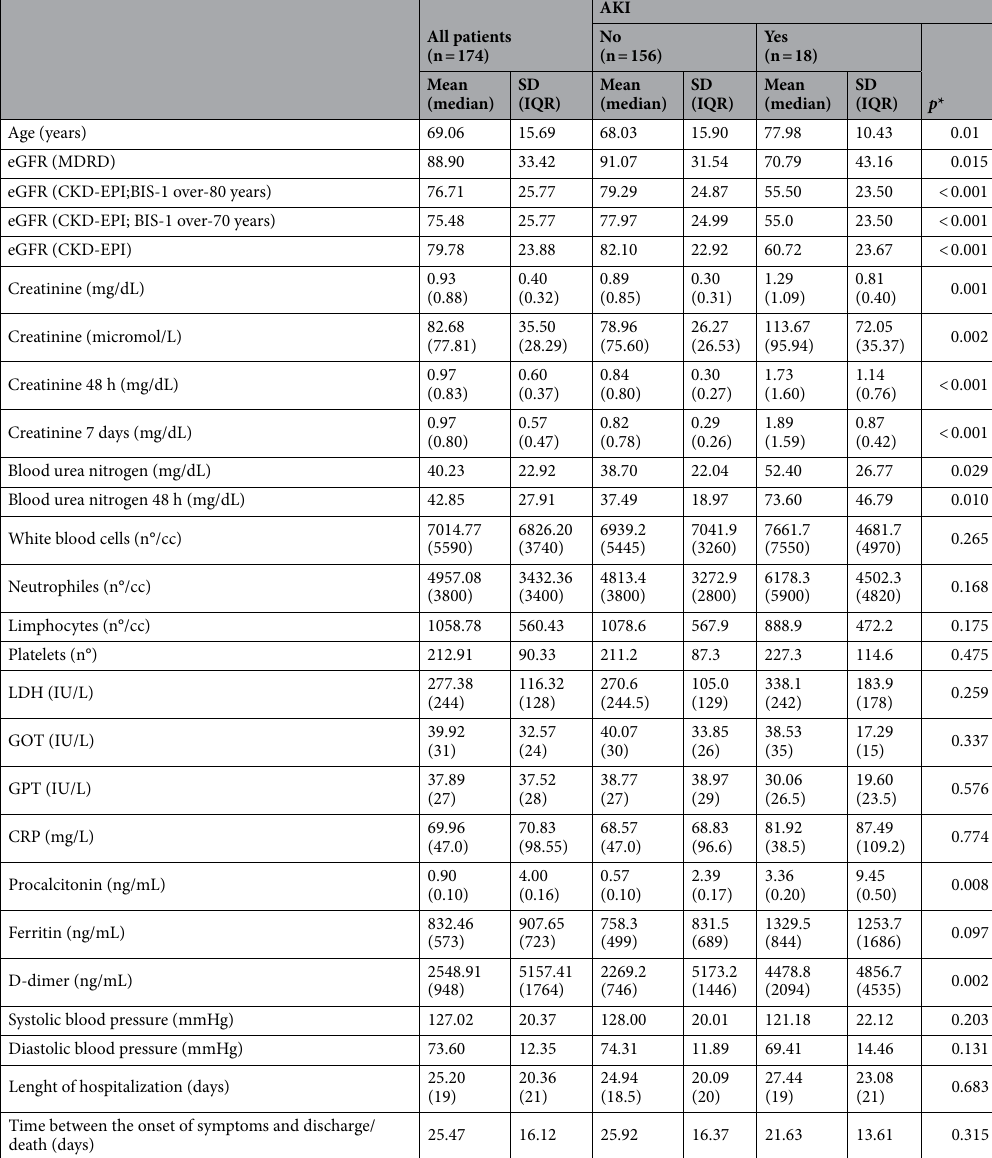
Table 1. Clinical characteristics of patients (whole sample and stratified by AKI). Median and Interquartile Range are shown for non normally distributed variables only. *Comparison between AKI and no AKI: Student’s t test or Mann–Whitney test, as appropriate. AKI = Acute Kidney Injury; SD = Standard Deviation; IQR = Interquartile Range; eGFR = Estimated Glomerular Filtration Rate; MDRD = Modification of Diet in Renal Disease Study; CKD-EPI = Chronic Kidney Disease Epidemiology Collaboration; BIS-1 = Berlin Initiative Study 1 Equation; LDH = Lactate Dehydrogenase; GOT = Glutamic Oxaloacetic Transaminase; GPT = Glutamate Pyruvate Transaminase; CRP = C-Reactive